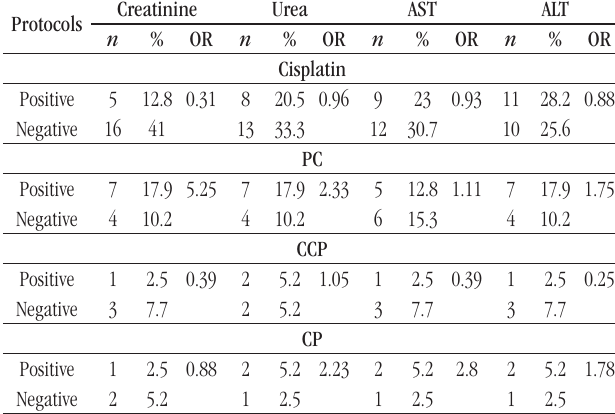
table 4 – Analysis of biochemical results, Caruaru, Pernambuco,